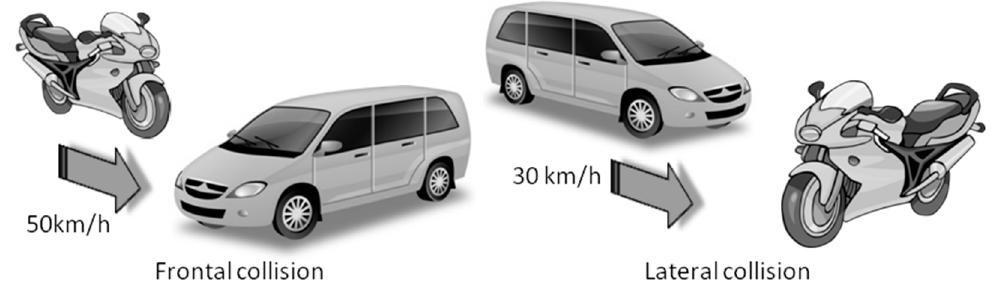
Figure 3. Collision tests between motorcycles and cars.